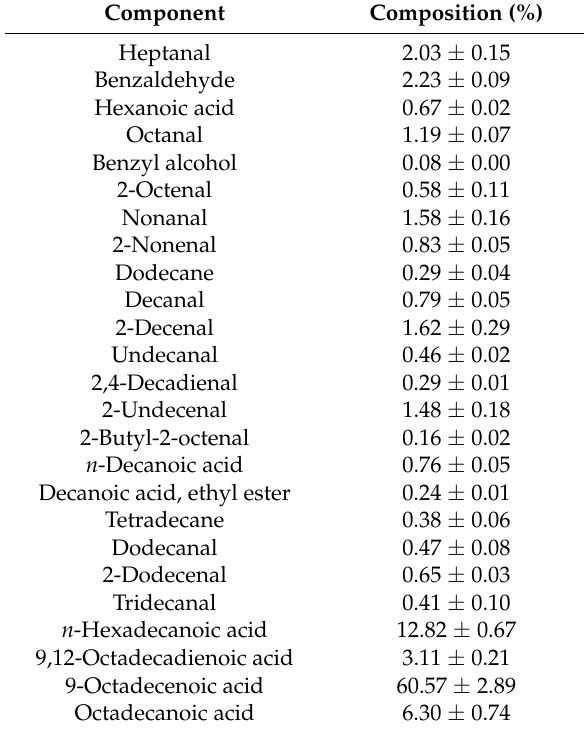
Table 5. Aroma volatile compounds of wild L. deliciosus